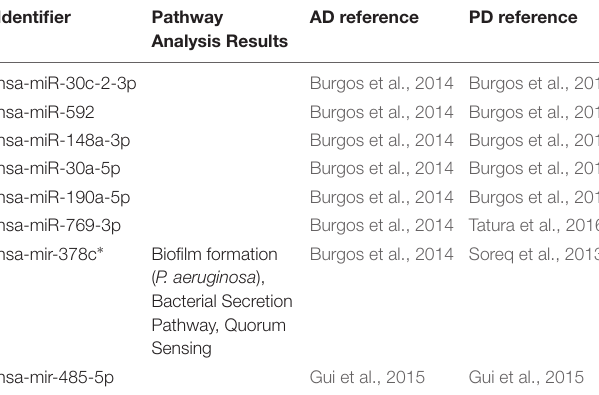
TABLE 1 | Commonly upregulated miRNAs in AD and